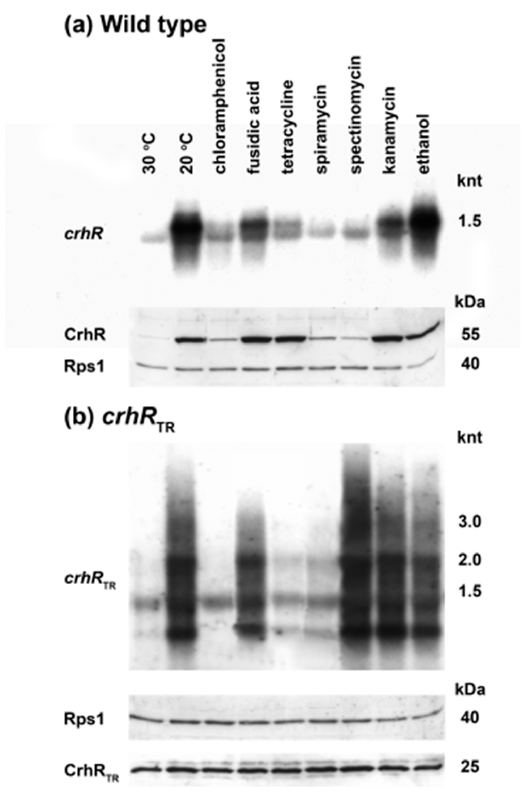
Figure 8. crhR translation is pre-initiated at 30 ◦ C. ( a ) Wild type and ( b ) crhR TR Synechocystis cells were grown to mid-log phase at 30 ◦ C. The effects on crhR transcript and CrhR protein accumulation were evaluated in the presence of inhibitors of translation initiation (kanamycin, fusidic acid and tetracycline) and translation elongation (chloramphenicol, spiramycin and spectinomycin). Ethanol, used to dissolve the antibiotics, was included as a control. The indicated antibiotics (150 mg/mL) were added and incubation continued for an additional 1 h at 30 ◦ C to fully inhibit de novo protein synthesis. Cultures were transferred to 20 ◦ C and incubated for 1 h for maximum induction of crhR expression. Aliquots from these cultures were harvested for RNA and soluble protein extraction were processed for northern and western analyses as described previously [27,32]. crhR (~1500 nt) and the truncated crhR TR (~750 nt) transcripts were detected from total RNA probed with a 93 bp Hinc II- Sac II internal fragment of crhR . Western blots using protein isolated from the cultures used for Northern analysis were simultaneously probed with antibodies against CrhR (55 kDa) and E. coli ribosomal protein S1 (Rps1, 40 kDa), used as a control for protein loading, and detected by ECL, as described in Figure